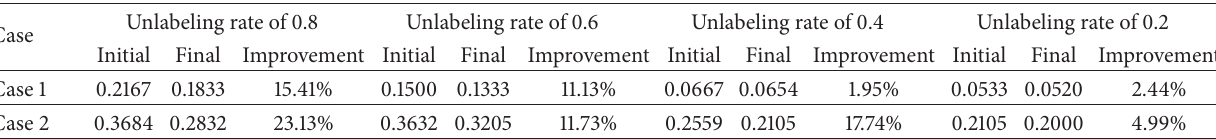
Table 7: Classification error rate of initial and final hypothesis and the corresponding improvements of tritraining under different unlabeling rate.